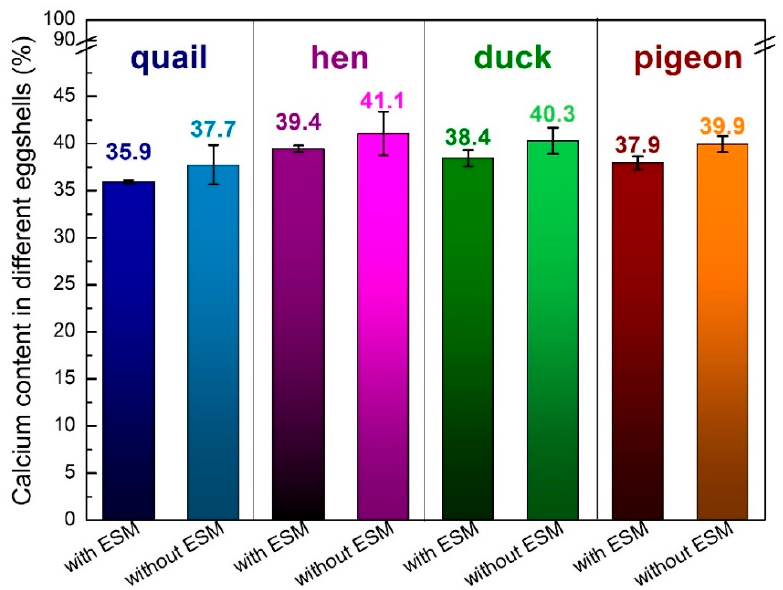
Figure 2. Calcium content (weight %) in the various poultry species eggshells with and without the eggshell membrane determined using the ICP-OES techniques.